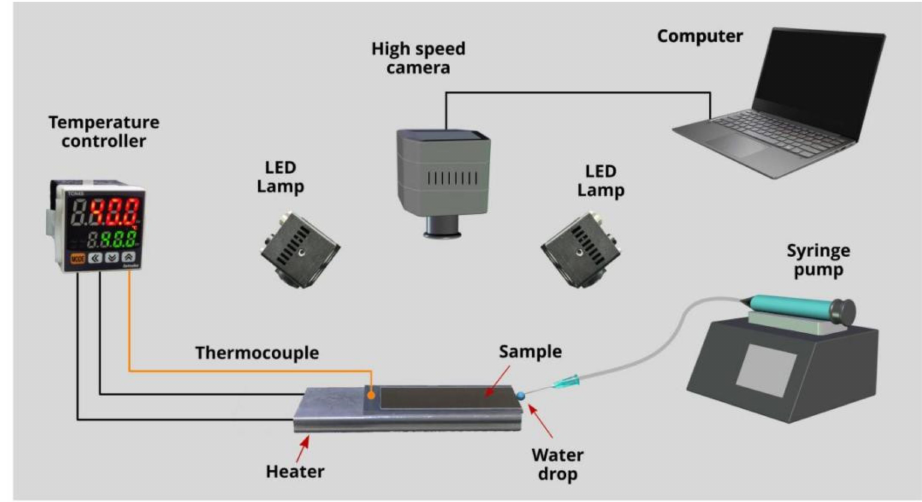
Figure 1. Experimental setup for high-speed video imaging of water spreading on a wicking surface at various